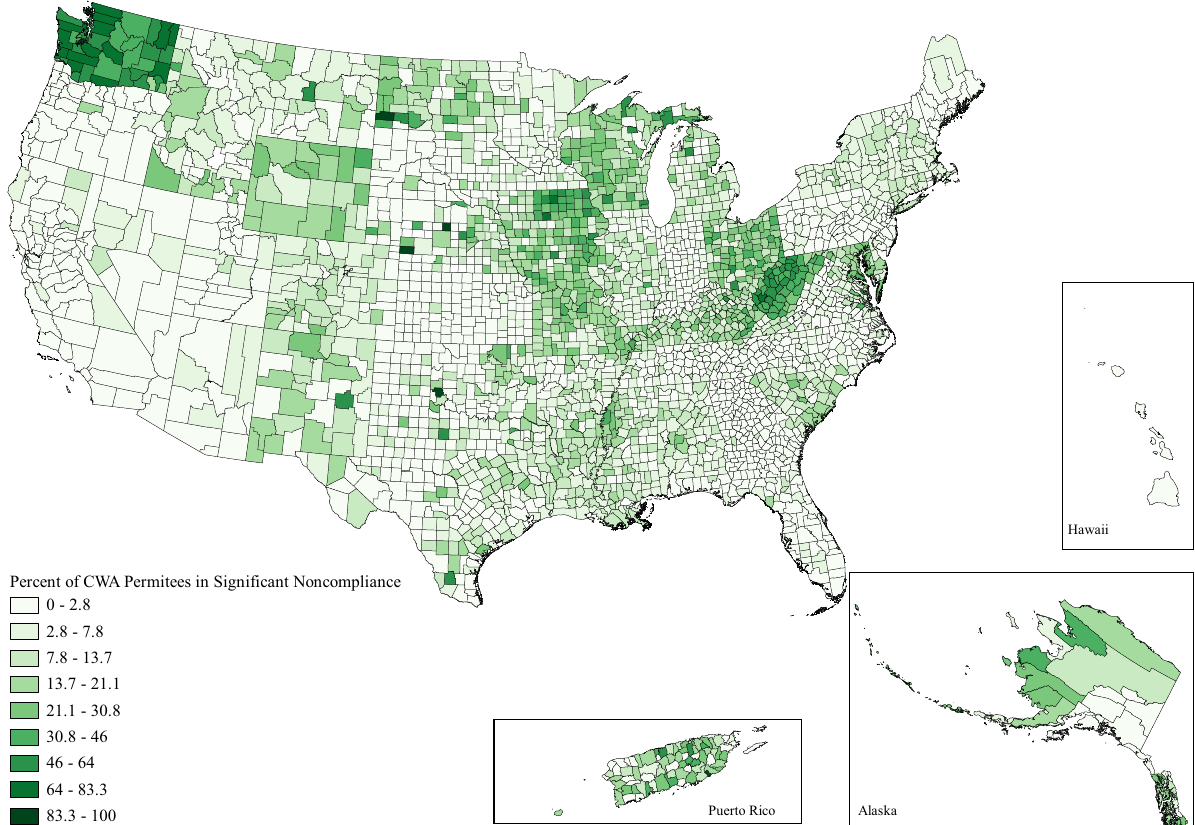
Fig. 3 Map of the percent of county Clean Water Act (CWA) permittees listed as Clean Water Act Signi fi cant Noncompliers. All facilities that discharge directly into water of the United States are issued a Clean Water Act permit, those who represent a more severe level of environmental threat due to violations and noncompliance are considered in Signi fi cant